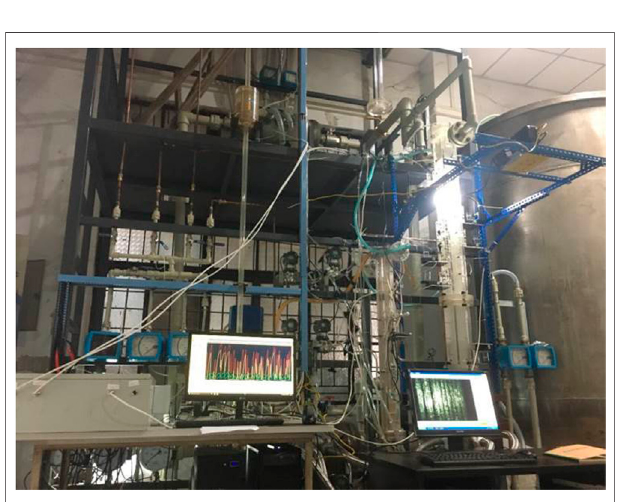
FIGURE 2 | A photograph of experimental system.